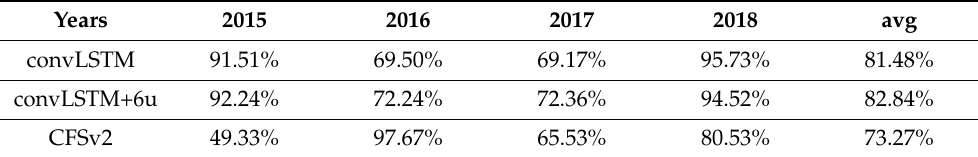
Table 3. The correlation of no_wind convLSTM model and wind convLSTM model and CFSv2 model from 2015 to 2018.